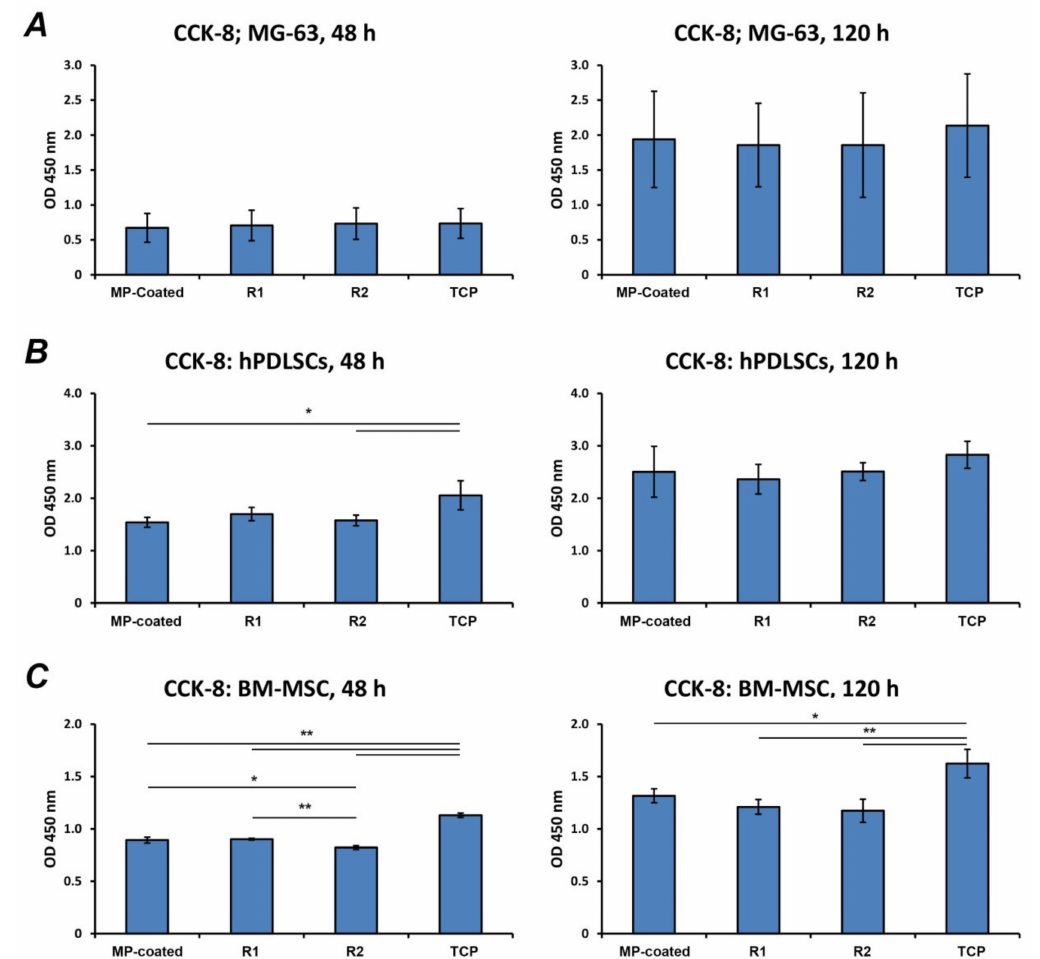
Figure 2. Proliferation / viability of di ff erent cells cultured on titanium surfaces and TCP.MG-63 cells ( A ), human periodontal ligament stem cells (hPDLSCs) ( B ), and bone marrow mesenchymal stem cells (BM-MSCs) ( C ) were cultured on multi-phosphonate (MP)-coated as well as sand-blasted and acid-etched reference surfaces (R1, R2), and cell proliferation / viability was assessed after 48 and 120 h by Cell Counting Kit-8 (CCK-8) experiments, which are based on the measurements of cell metabolic activity. Cells cultivated on tissue culture plastic (TCP) served as control. The Y-axis corresponds to the optical density (OD) values assessed at 450 nm. Data are presented as mean ± standard error of the mean (S.E.M) of three experiments that were conducted independently. * and **—significantly di ff erent between groups with p < 0.05 and p < 0.01,